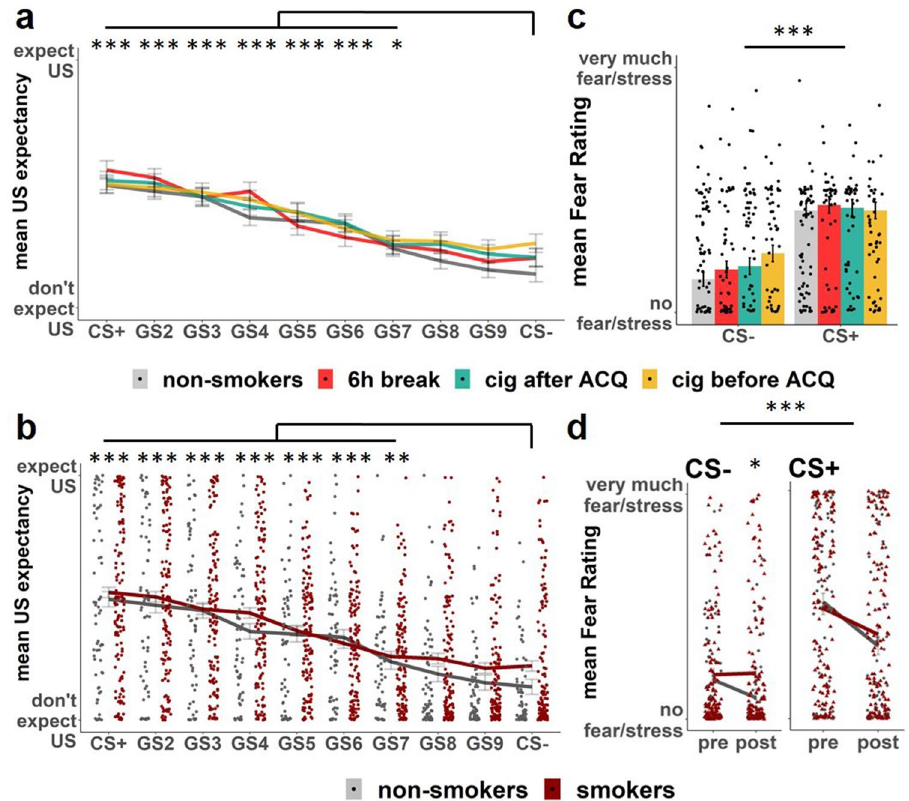
Figure 2. Rating results generalization test Day 2. Stimuli were presented in random order. Participants rated their US expectancy for every trial and their fear before and after the generalization test. Individual representations indicate the mean for each subject. ( a ) Day 2 mean US expectancy for each group per stimulus. Participants differentiated between the CS- and all stimuli between CS + and GS7 on Day 2. There were no group differences. ( b ) Day 2 mean US expectancy for all stimuli, smokers versus non-smokers. There were no group differences. ( c ) Day 2 mean fear rating for each group. No group differences were found. ( d ) Day 2 fear ratings smokers versus non-smokers. Following the colour, grey circles represent non-smokers and red triangles represent smokers. Non-smokers rated their fear/stress towards the CS- lower after the experiment when compared to smokers. [***] indicates p < 0.001. [**] indicates p < 0.01. [*] indicates p <